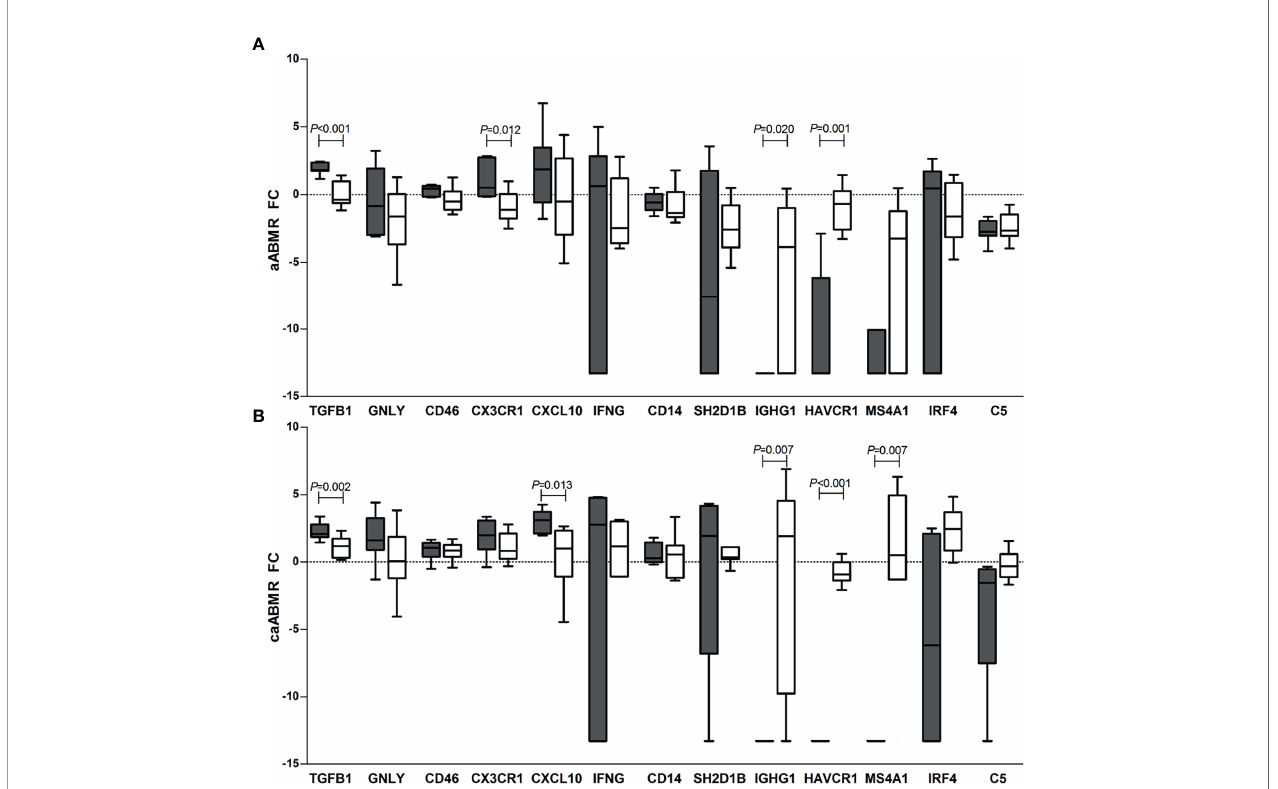
FIGURE 3 | Differences in gene expression (log2 FC) between glomeruli (G, dark bars) and tubulointerstitium (TI, empty bars) in the groups with: (A) active ABMR (aABMR, n=10), and (B) chronic active ABMR (caABMR, n=10). Boxes extends from the 25th to 75th percentiles, lines in the middle of the box shows median and whiskers indicate the highest and lowest value within inner fences (Tukey whiskers). Differences are calculated by Mann-Whitney